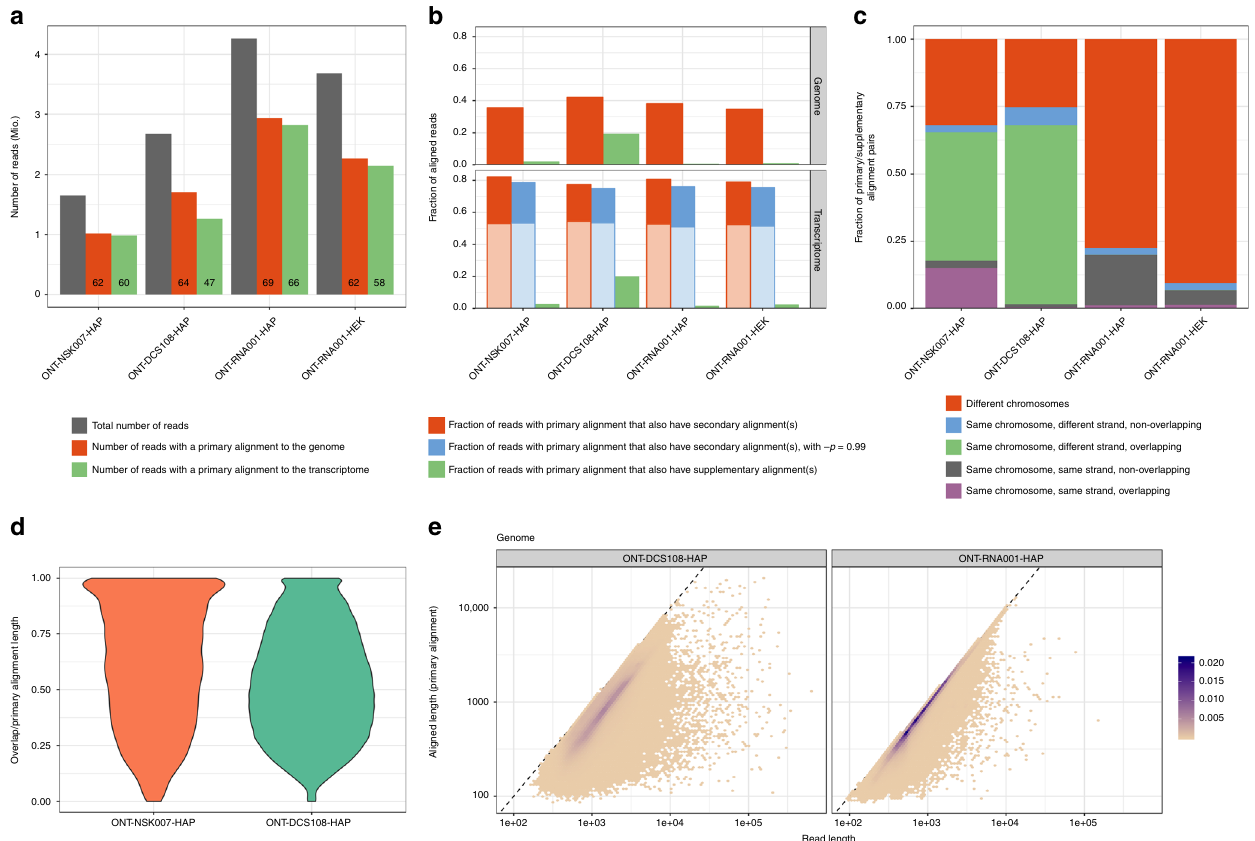
Fig. 2 Characterization of aligned reads. a Total number of reads and number of reads with a primary alignment to the genome and transcriptome, respectively, in each of the ONT data sets. The number displayed in each bar represents the alignment rate in % (the fraction of the total number of reads for which minimap2 reports an alignment). b Fraction of the reads with a primary alignment to the genome or transcriptome, respectively, that also have at least one reported secondary or supplementary alignment. The lighter shaded parts of the secondary transcriptome alignment bars correspond to reads where all primary and secondary alignments are to isoforms of the same gene, while the darker shaded parts correspond to reads with reported alignments to transcripts from different genes. c Investigation of supplementary genome alignments. Each supplementary alignment is categorized based on whether it is on the same chromosome and strand as the primary alignment, and if the alignment positions of the primary and supplementary alignments overlap. d Length of the overlap between the primary and supplementary alignments, divided by the primary alignment length (number of M and D characters in the CIGAR string), for supplementary alignments falling on the same chromosome, but different strand, and overlapping, the primary alignment (light green fractions in panel c ). e Total read length ( x ) vs aligned length ( y , the sum of the number of M and I characters in the CIGAR string) for the primary genome alignment of each read, summarized across the replicates in the ONT-DCS108-HAP and ONT-RNA001-HAP data sets. The color indicates point density. Source data for panels a – c are provided as a Source Data fi